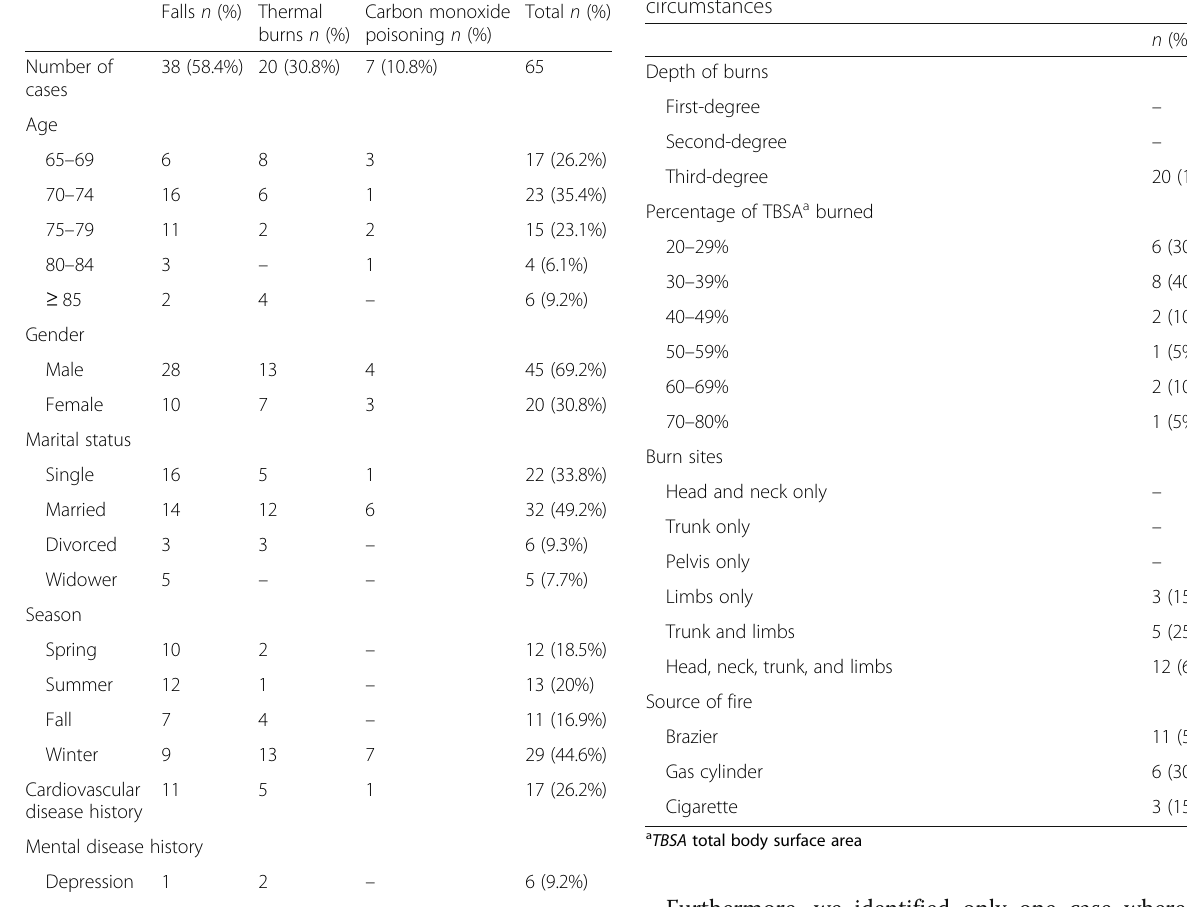
Table 3 Distribution of domestic accidents epidemiological data